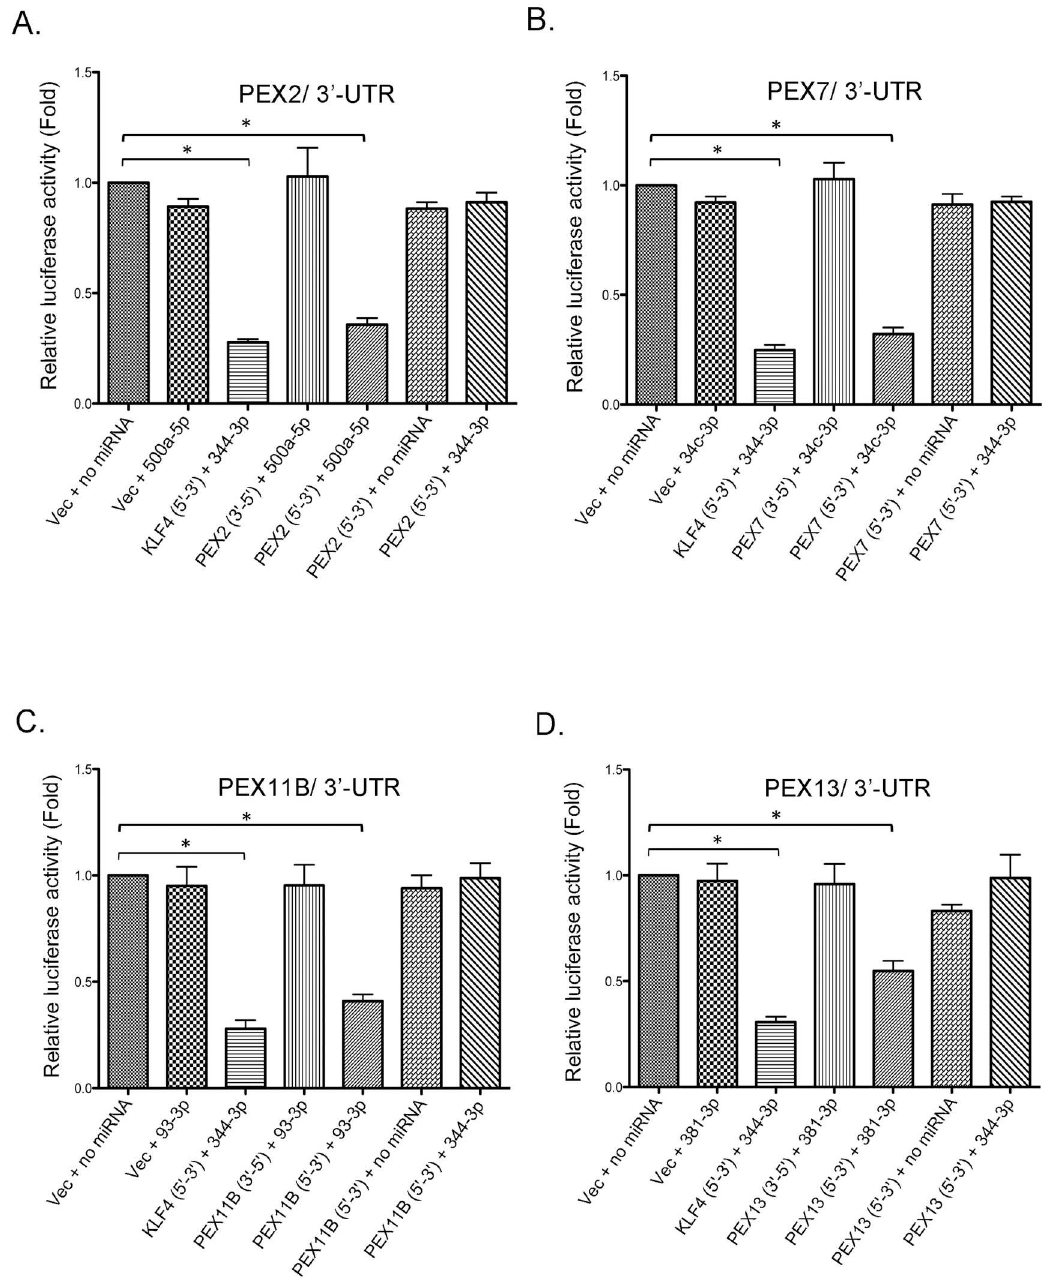
Fig 2. A subset of HAND-associated miRNAs negatively regulate expression of PEX mRNAs. HEK293T cells were co-transfected with luciferase reporter plasmids(pMIR-REPORT-Luciferase) containing3’-UTRs from PEX2 (A), PEX7 (B), PEX11B (C) and PEX13 (D) in forward (5’-3’) or reverse orientations (3’-5’), a transfection control reporter plasmid (pMIR-REPORT- β -gal) and miRNA mimics for miR-500a-5p, miR-34c-3p, miR-93-3p, miR-381-3p and miR-344-3p. After 48 hours, cell lysates were subjectedto luciferaseand β -gal assays. N = 3. Bars represent standarderror of the mean. Key to plasmids: Vec = pMIR-REPORT-Luciferase; KLF4 = pMIR-REPORT-Luciferase with 3’ UTR of KLF4 downstream from luciferase cassette; PEX2 = pMIR-REPORT-Luciferase with 3’ UTR of PEX2 downstreamfrom luciferase cassette; PEX7 = pMIR-REPORT-Luciferase with 3’ UTR of PEX7 downstreamfrom luciferasecassette; PEX11B = pMIR-REPORT-Luciferase with 3’ UTR of PEX11B downstreamfrom luciferase cassette; PEX13 = pMIR- REPORT-Luciferasewith 3’ UTR of PEX13 downstream from luciferase cassette. As a positive control, miR-344-3p is shownto downregulate expressionof luciferase under the control of the 3’UTR of KLF4 mRNA.